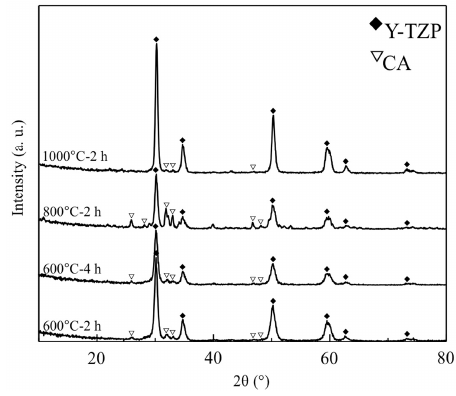
Figure 4. XRD patterns of CA films on the 600 °C ‐ 2 h, 800 °C ‐ 2 h, 1000 °C ‐ 2 h, and 600 °C ‐ 4 h Y ‐ TZP disks. ♦ : Y ‐ TZP substrate, ▽ : Carbonate apatite.